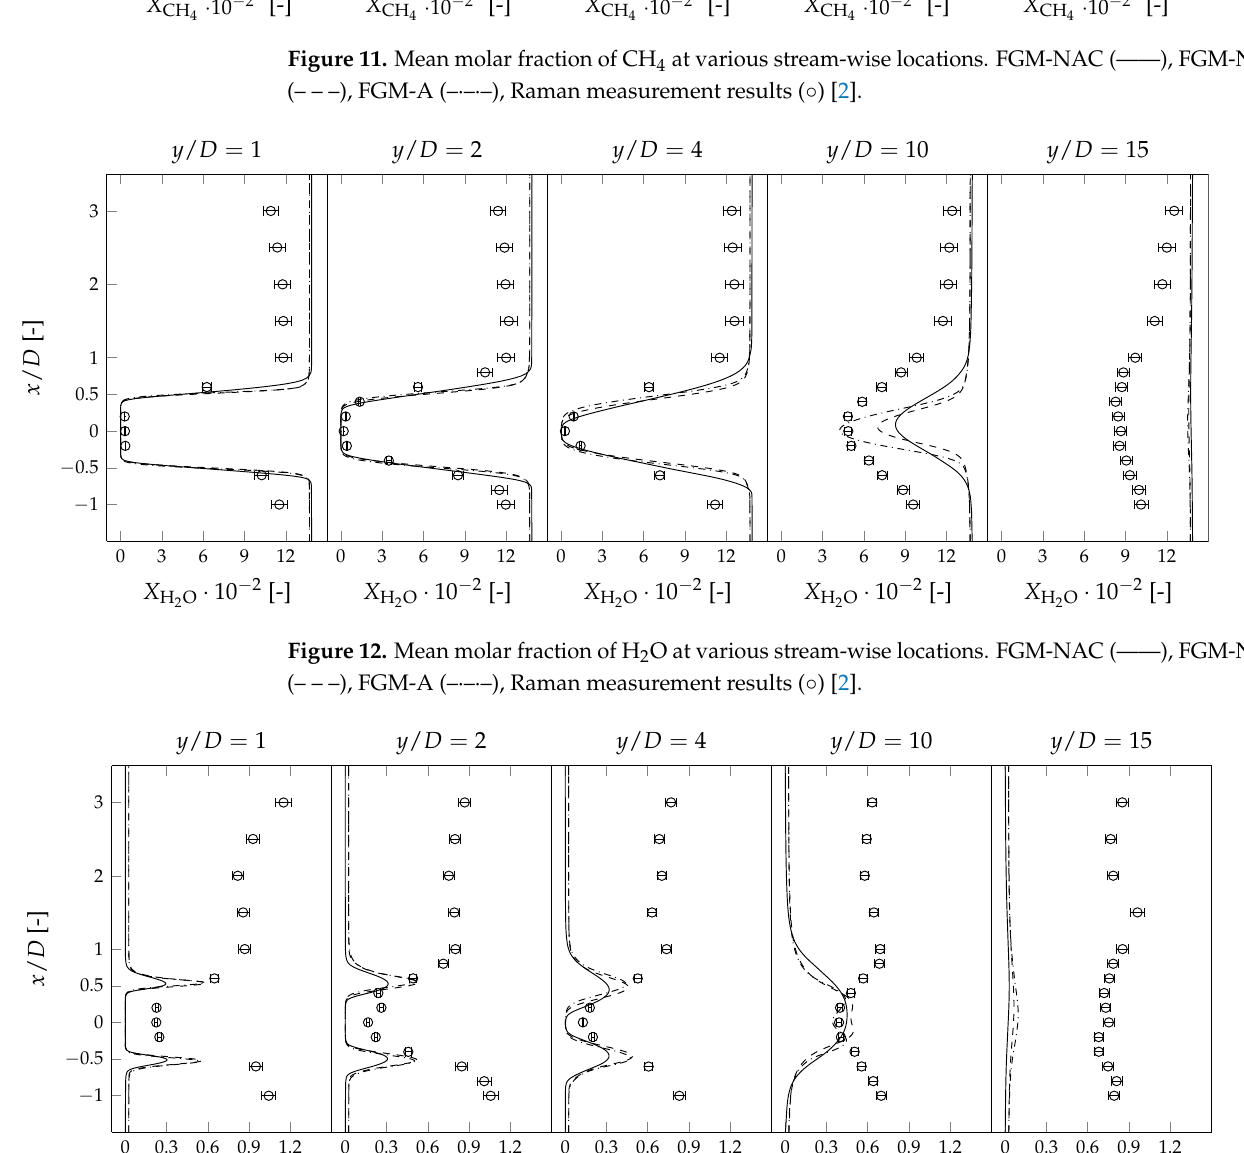
Figure 17. Mean molar fraction of H 2 at various stream-wise locations. FGM-NAC ( ), FGM-NA ( ), FGM-A ( ), Raman measurement results ( ) [2].